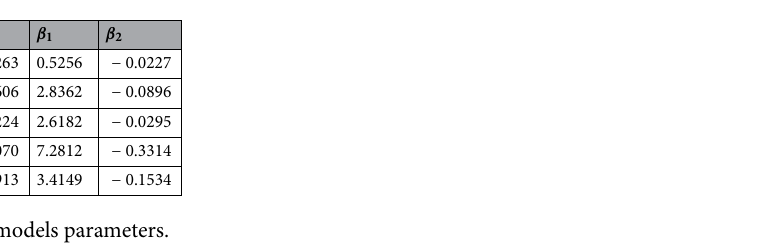
Table 3. Regression models